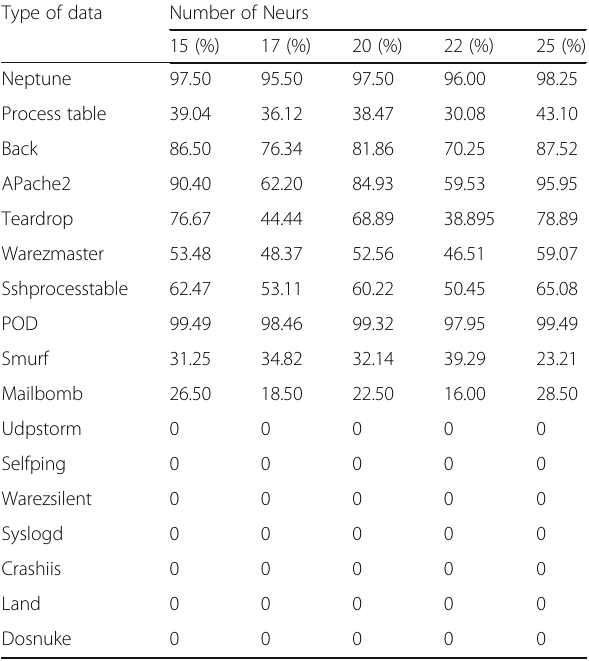
Table 4 Attack sample detection comparison Type of